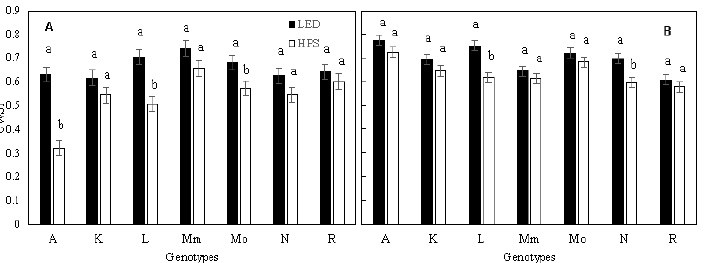
Figure 2. Crop water stress index (CWSI) per genotype, grown under HPS and LED supplemental light. Values are the average of 3 plants per genotype in experiment 2 ( A ) and experiment 3 ( B ). Different letters above bars within a panel and for each genotype separately indicate significant differences according to Fisher’s protected LSD test ( p = 0.05). Error bars show ± SD. A—Ailsa Craig; K—Kentucky Beefsteak; L—LA1578; Mm—Moneymaker; Mo—Momotaro; N—Nunhems-FM001; R—Rutgers.